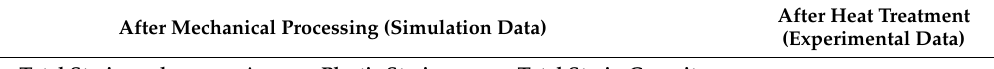
Table 2. Characteristics of strength and elastic-plasticity for simulation models of composite materials with a micromechanical approach (first stage).